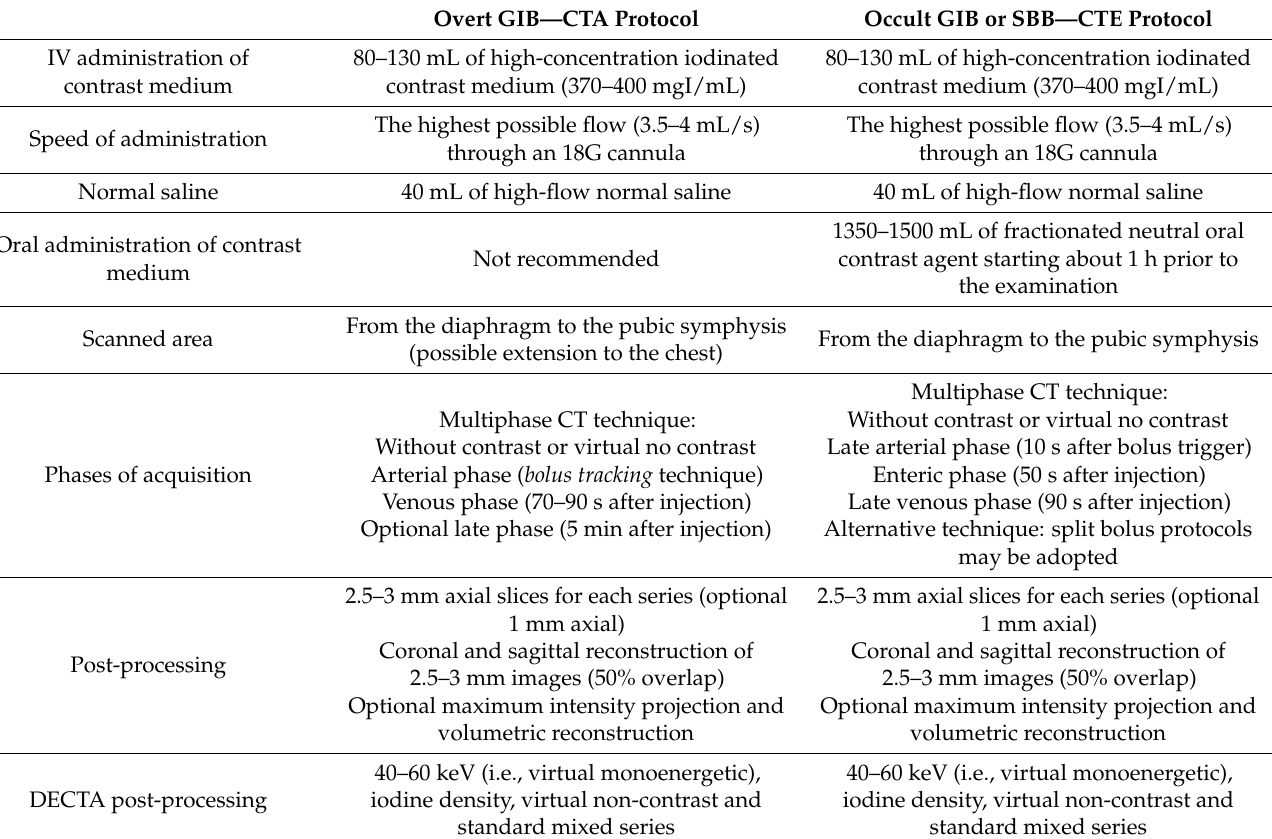
Table 3. CTA protocol for overt GIB and optional CTE protocol for occult GIB or SBB.